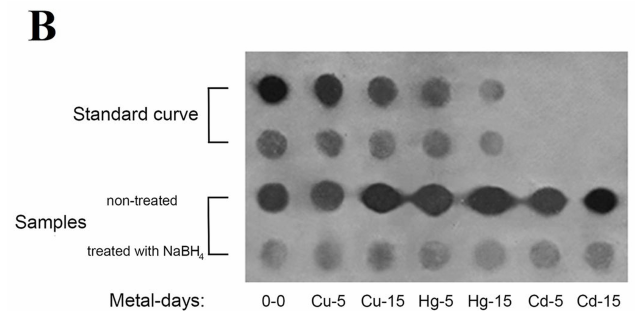
Figure 2. ( A ) A representative standard curve of 2,4-dinitrophenylhydrazine (DNPH) dot blot analysis